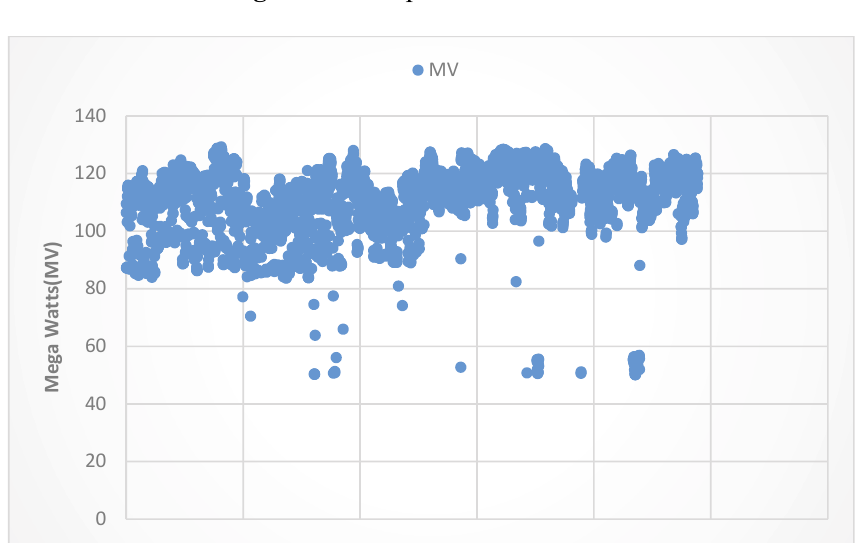
Fig. 5. ST output